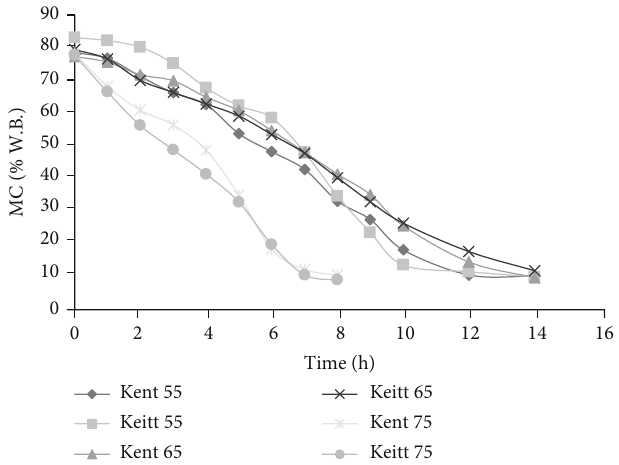
Figure 3: Moisture content of Kent and Keitt during